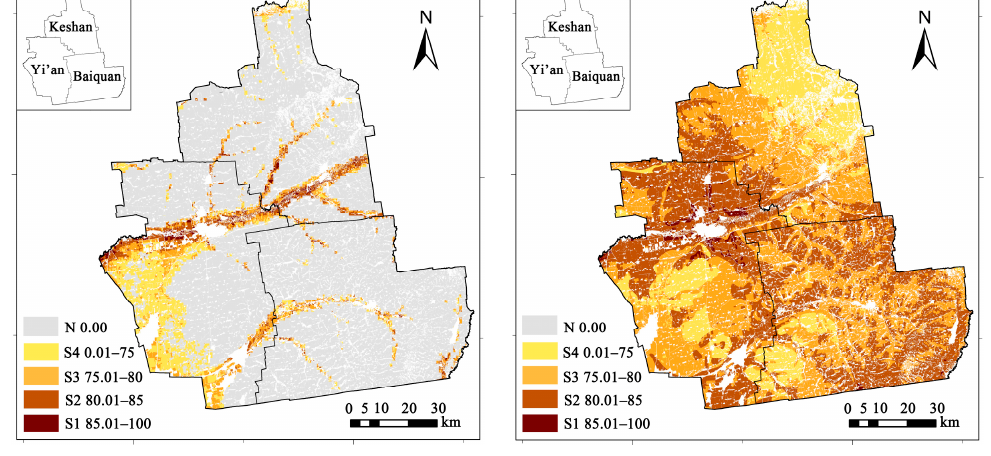
(a) Planting suitability map of rice. (b) Planting suitability map of maize.